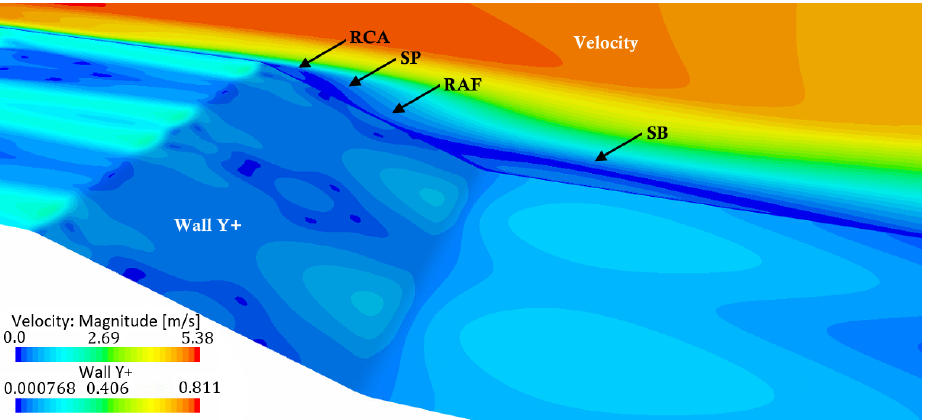
Figure 13. Simulated flow separation affected by the knitted wire mesh with two rows. The velocity is shown on the plane R in between two stitches. On the bottom channel walls, the y+ value is presented. SB denotes a separation bubble, SP a stagnation point, RCA a recirculation area and RAF a reattached flow.